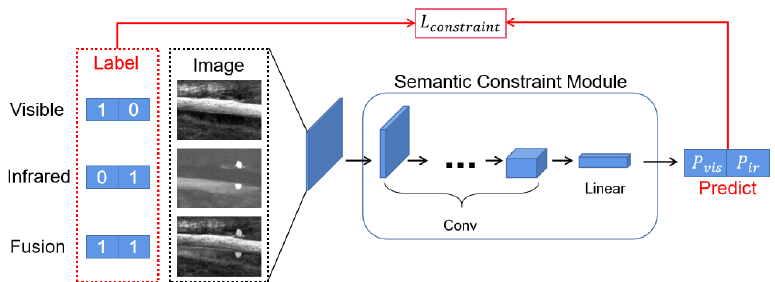
Figure 5. The overall workflow of the Semantic Constraint module.